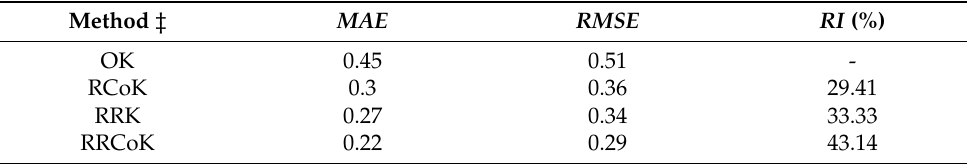
Table 5. Validation indices † for the four spatial prediction